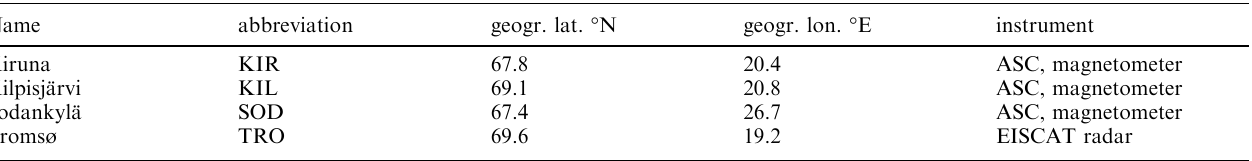
Table 2. Geographic locations of the ground-based stations mentioned in the text Name